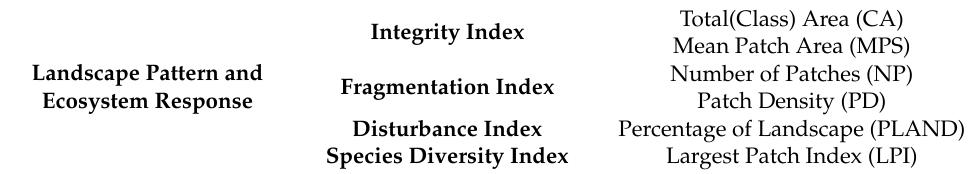
Table 1. Landscape pattern index